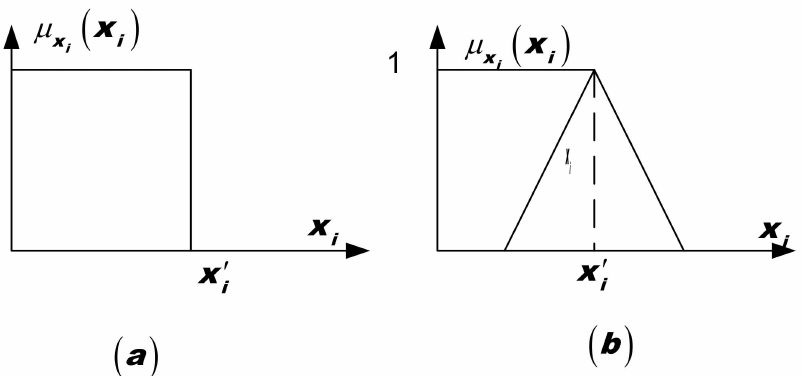
Figure 8. Singleton and non-singleton for type-1 fuzzy. ( a ) Fuzzifier: Singleton or Non-Singleton; ( b ) Rule base.